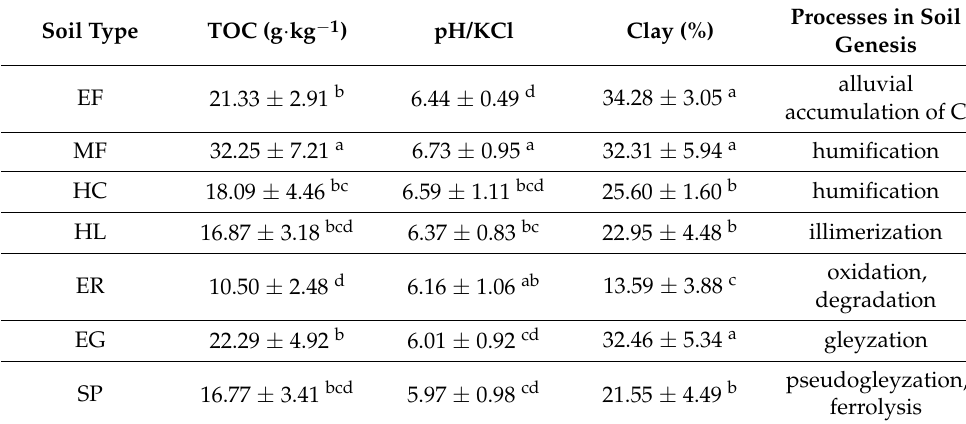
Table 2. Average values of basic pedological characteristics of the soil